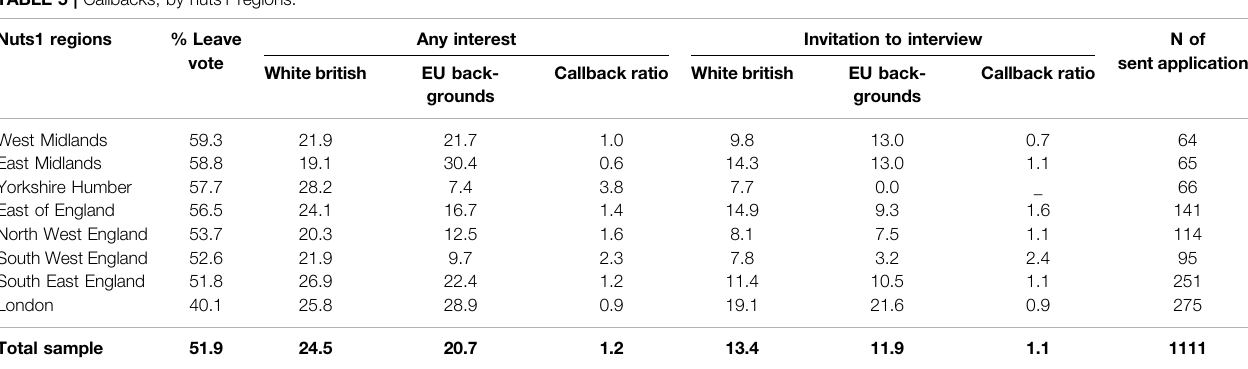
TABLE 5 | Callbacks, by nuts1 regions. Nuts1 regions